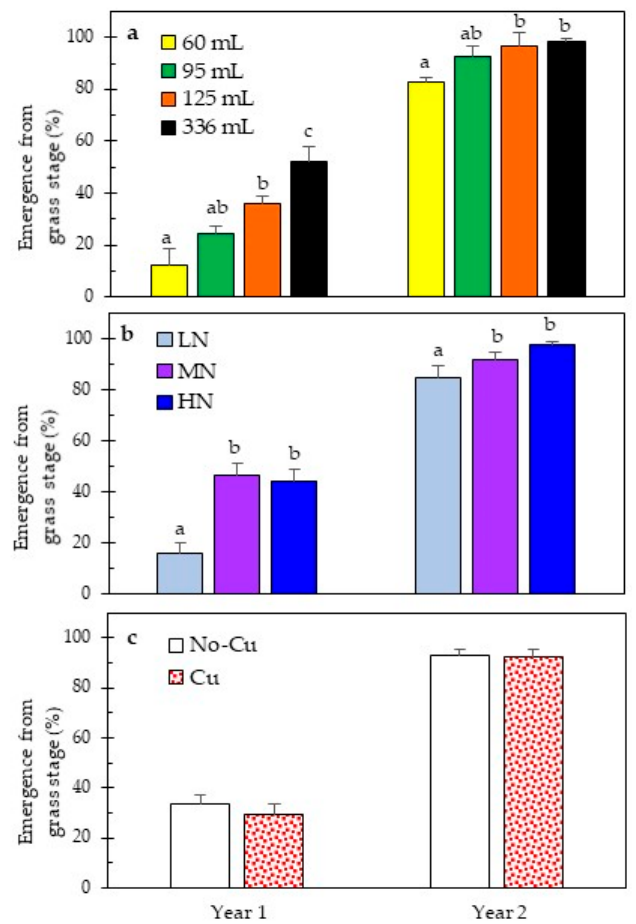
Figure 2. Percent emergence from the grass stage by longleaf pine seedlings in response to nursery treatments during the first two years after outplanting. ( a ) Cavity volume; ( b ) nitrogen rate: low (LN), medium (MN), and high (HN); and ( c ) copper (Cu) root pruning. Within a treatment and year, the same letter indicates no significant differences at the Bonferroni-adjusted 0.05 level. Error bars represent 1 SE.